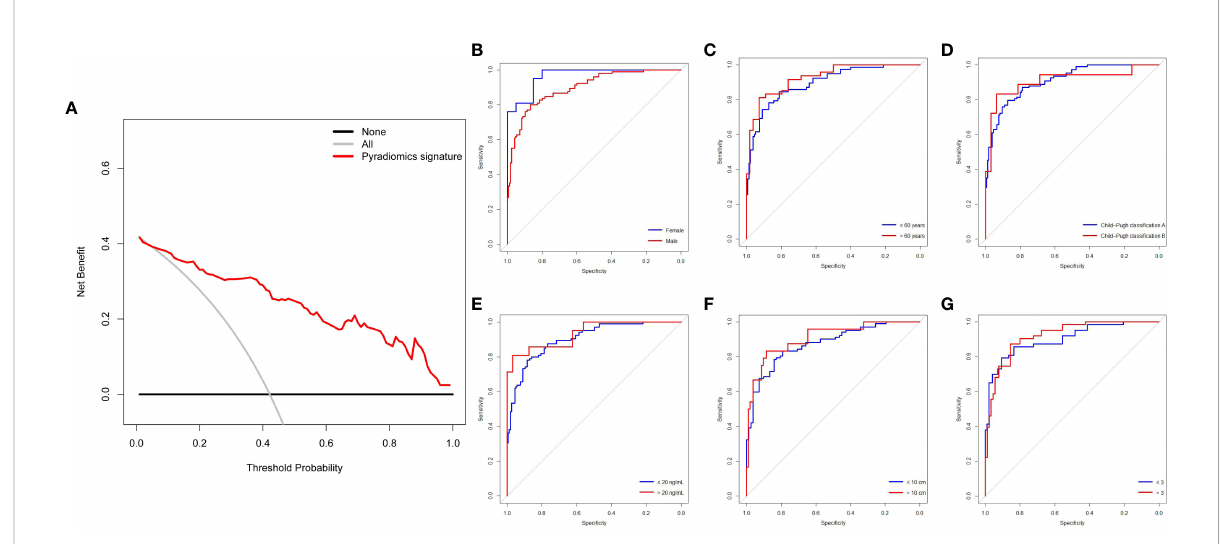
FIGURE 4 DCA and subgroup analysis of the pyradiomics signature for predictive treatment response to TACE. (A) DCA of the pyradiomics signature. (B-G) Pyradiomics signature of clinical subgroup predicts therapy response in all patients (n=313) undergoing TACE treatment. The two ROC curves are compared using the bootstrap (n=2000) test. DCA, decision curve analysis; ROC, receiver operating characteristic; TACE, transarterial